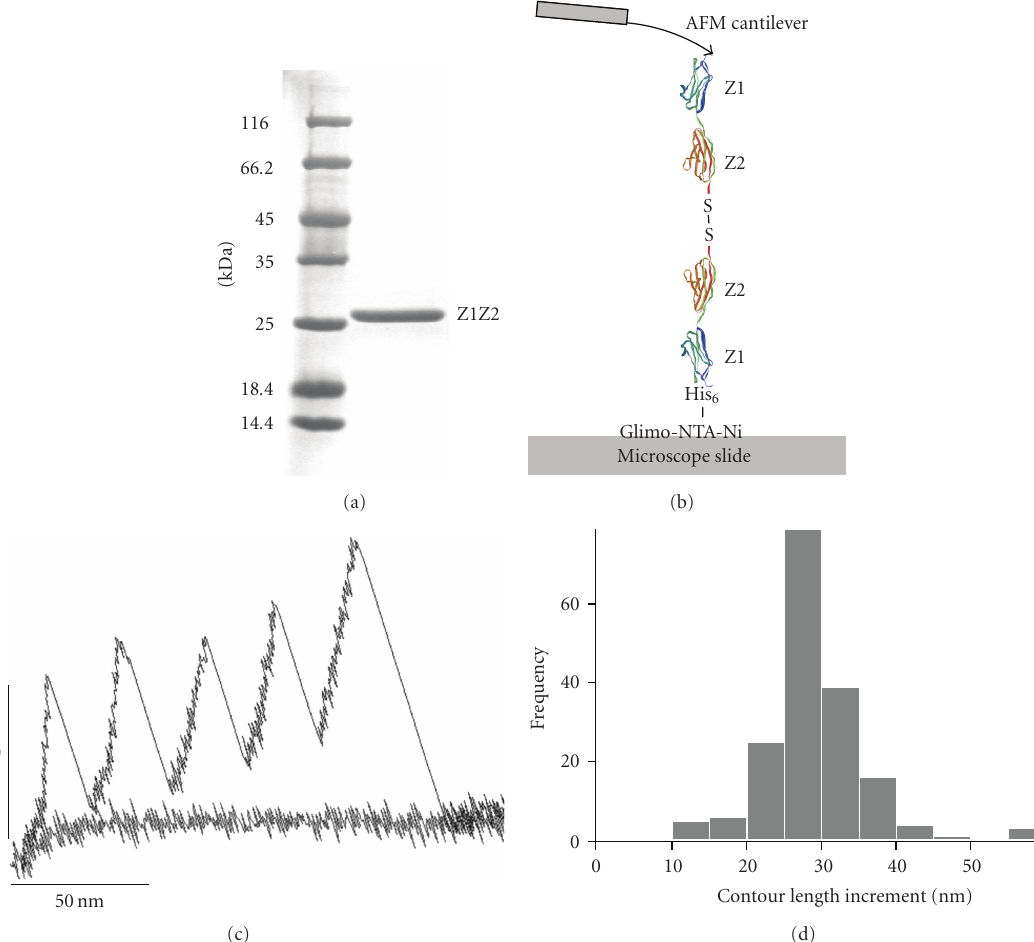
Figure 2: (a) SDS-polyacrylamide electrophoretogram of the recombinant Z1Z2 fragment. (b) Nanomechanical manipulation of the Z1Z2 chemical dimer. The molecular design of the Z1Z2 chemical dimer is indicated. Two recombinant Z1Z2 modules, each with a His 6 -tag at its N-terminus and a cysteine at its C-terminus, respectively, are dimerized via a disulphide bond under oxidizing conditions. The dimer is manipulated by using single-molecule AFM. (c) Force versus end-to-end length curve of a Z1Z2 dimer. The first four sawtooth peaks correspond to the unfolding of each of the four domains (two Z1 and two Z2), and the fifth peak corresponds to the final dissociation of the complex from either the AFM tip or the substrate surface. (d) Distribution of contour-length gain during the sawtooth force transitions. Average contour-length gain per transition was 29 . 1 ± 0 . 6 nm ( ±